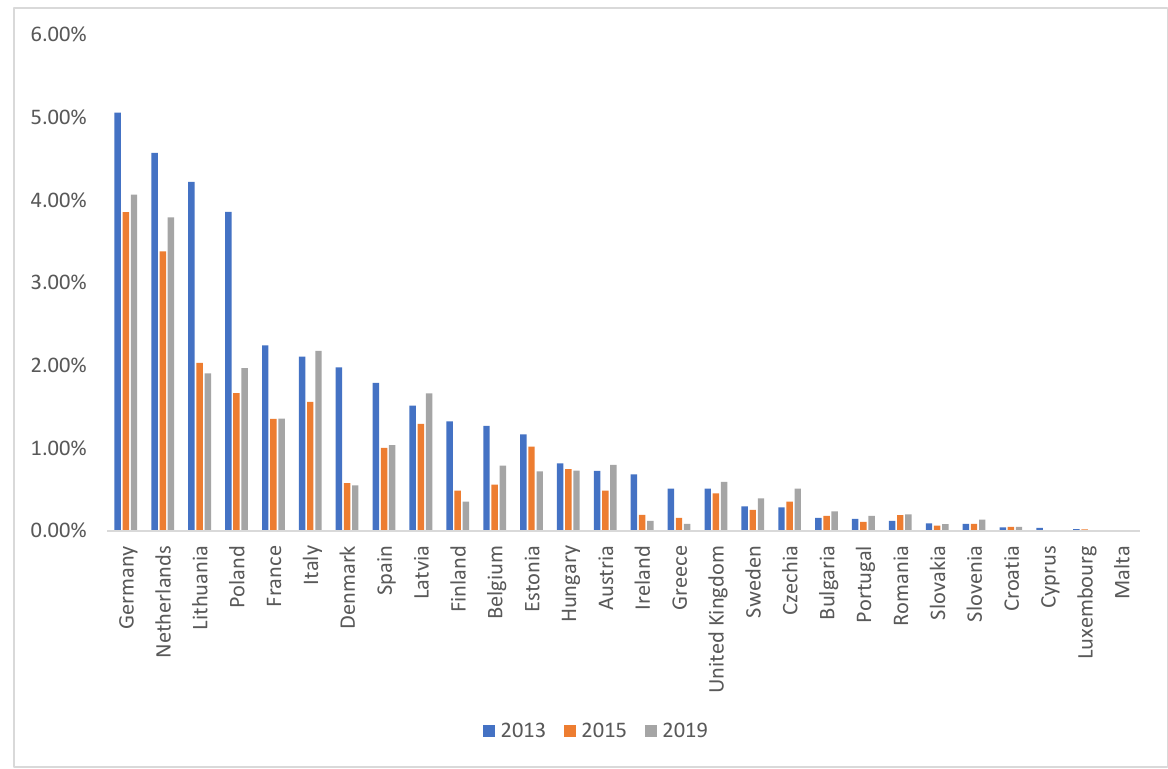
Figure 3. Shares of the EU28 countries in the agri-food imports of Russia. Source: Authors’ own calculations based on UN COMTRADE data.